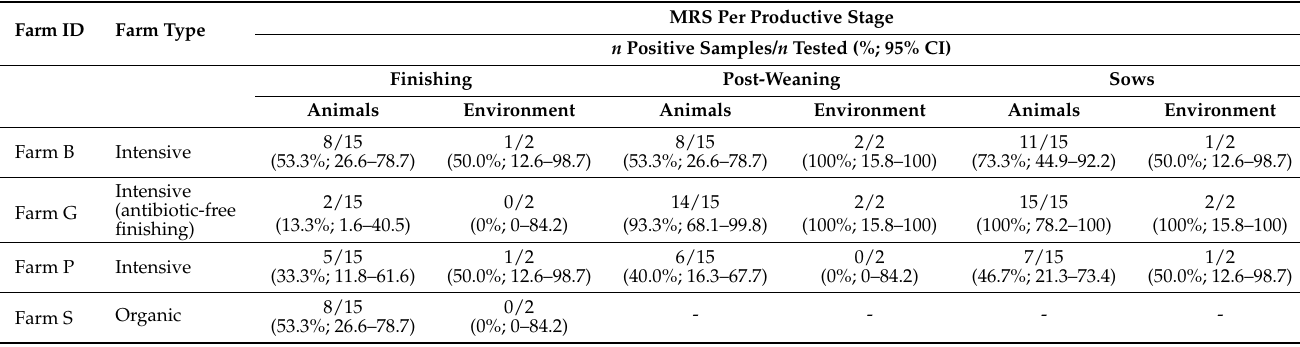
Table 2. Methicillin-resistant staphylococci (MRS) isolated from animals (nasal swabs) and the environment in five farms in northern Italy, 2019–2020, by productive stage. All isolates were MRCoNS except from one MRSA in farm T (indicated by an